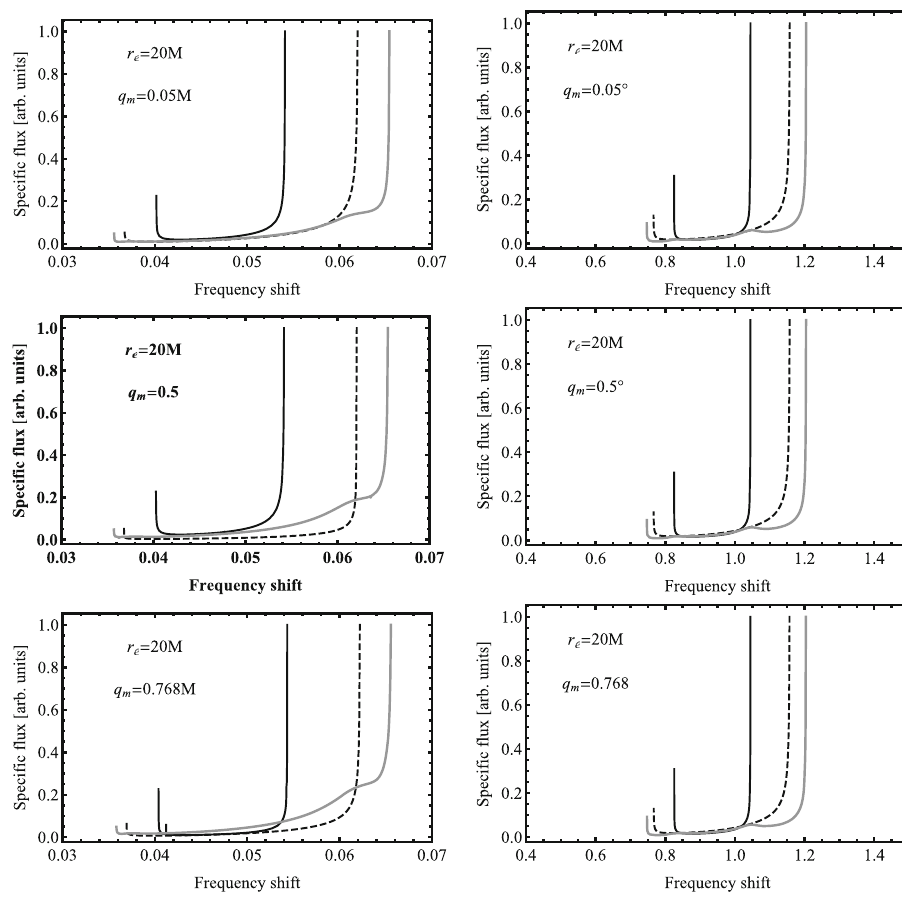
Fig. 6 Ring profiled spectral line generated. Illustration of observer inclination angle effect on spectral line properties constructed for three representative values of “magnetic charge” parameter q m = 0 . 05 M (top), 0 . 5 M , and 0 . 768 M (bottom) and three values of observer’s inclination angles θ o = 30 ◦ (black), 60 ◦ (black, dashed), and 85 ◦ (thick, gray). The ring radius is r e = 20